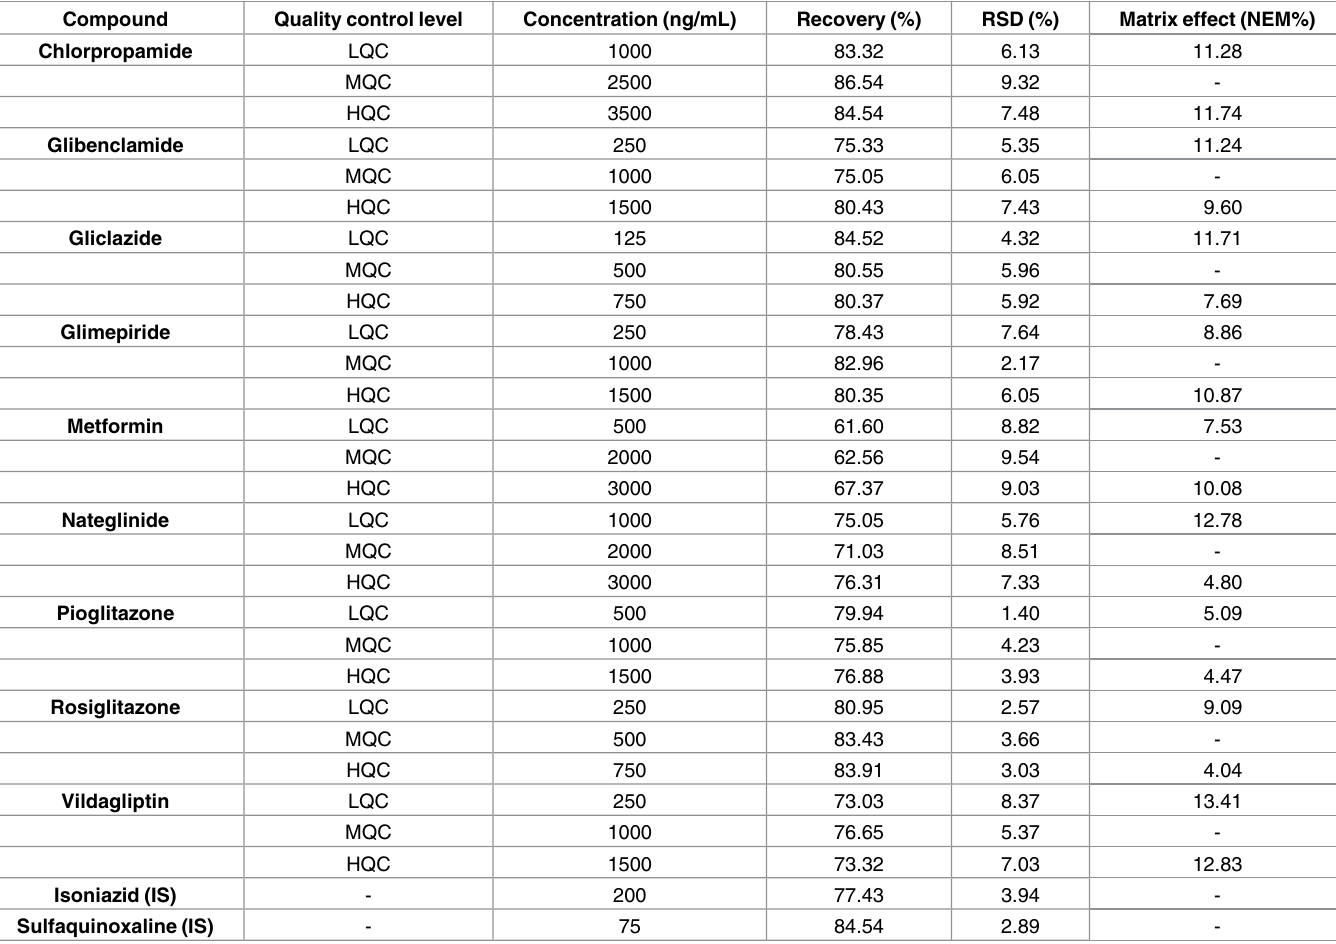
Table 3. Recoveryand matrix effect of the antidiabetic agents and internal